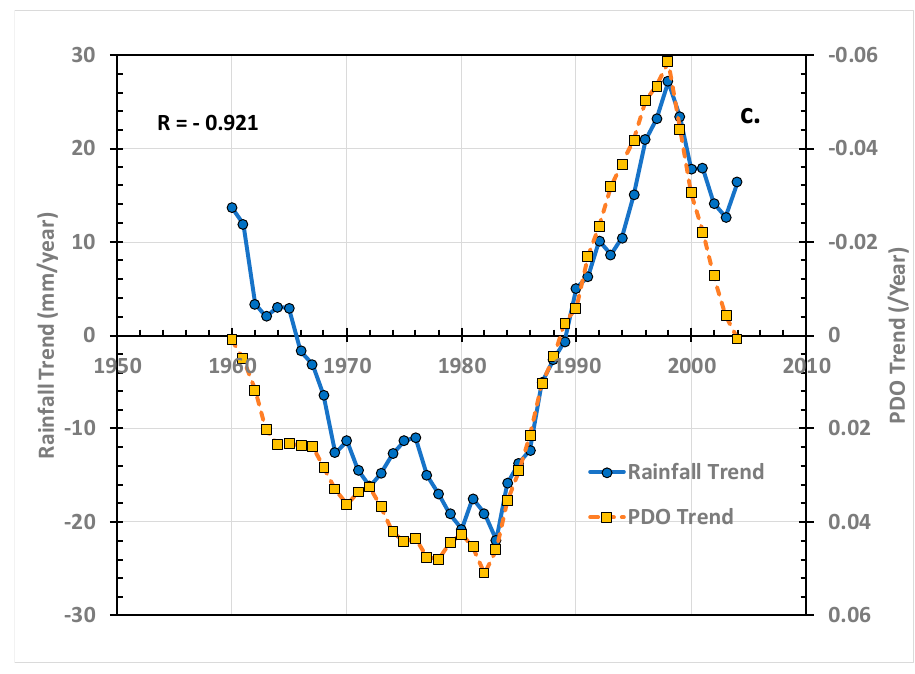
Figure 4. Comparison between the trends in rainfall at Nuku’alofa over 31 year consecutive periods and the consecutive trends in the PDO over the same period. The correlation, − 0.921, is highly significant. The year shown is the midyear of the 31-year period.